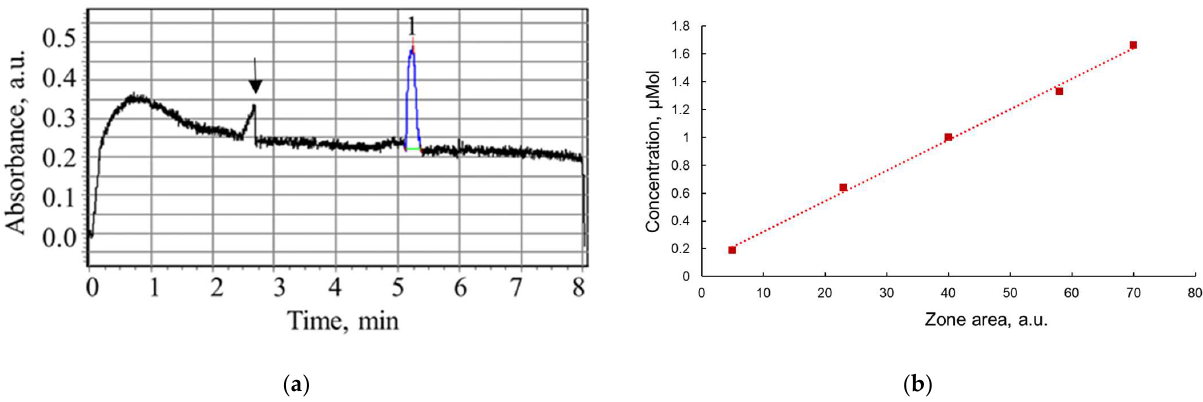
Figure 8. Electropherogram of peptide LETI-11 (1), concentration 3.6 μM, Tris 0.01 M buffer pH 7.2, U = 20 kV, capillary length 50 cm, detection wavelength 200 nm. The leading peak reflects the system zone indicating the buffer velocity. Capillary treatment type A, the arrow shows the systemic peak corresponding to the electroosmotic flow velocity ( a ); relationship of LETI-11 zone areas, S (in arbitrary units) versus molar peptide LETI-11 concentrations ( b ).